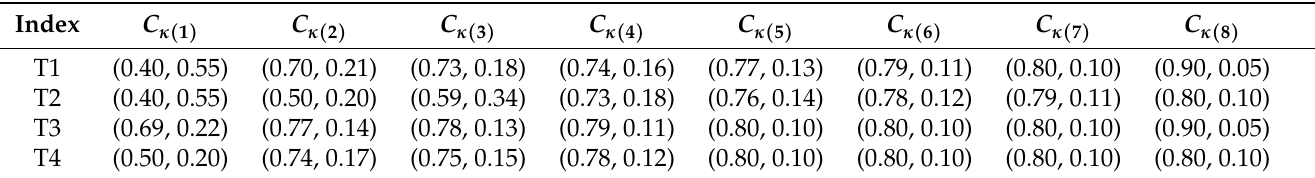
Table 5. The rearranged IFS matrix of the air target